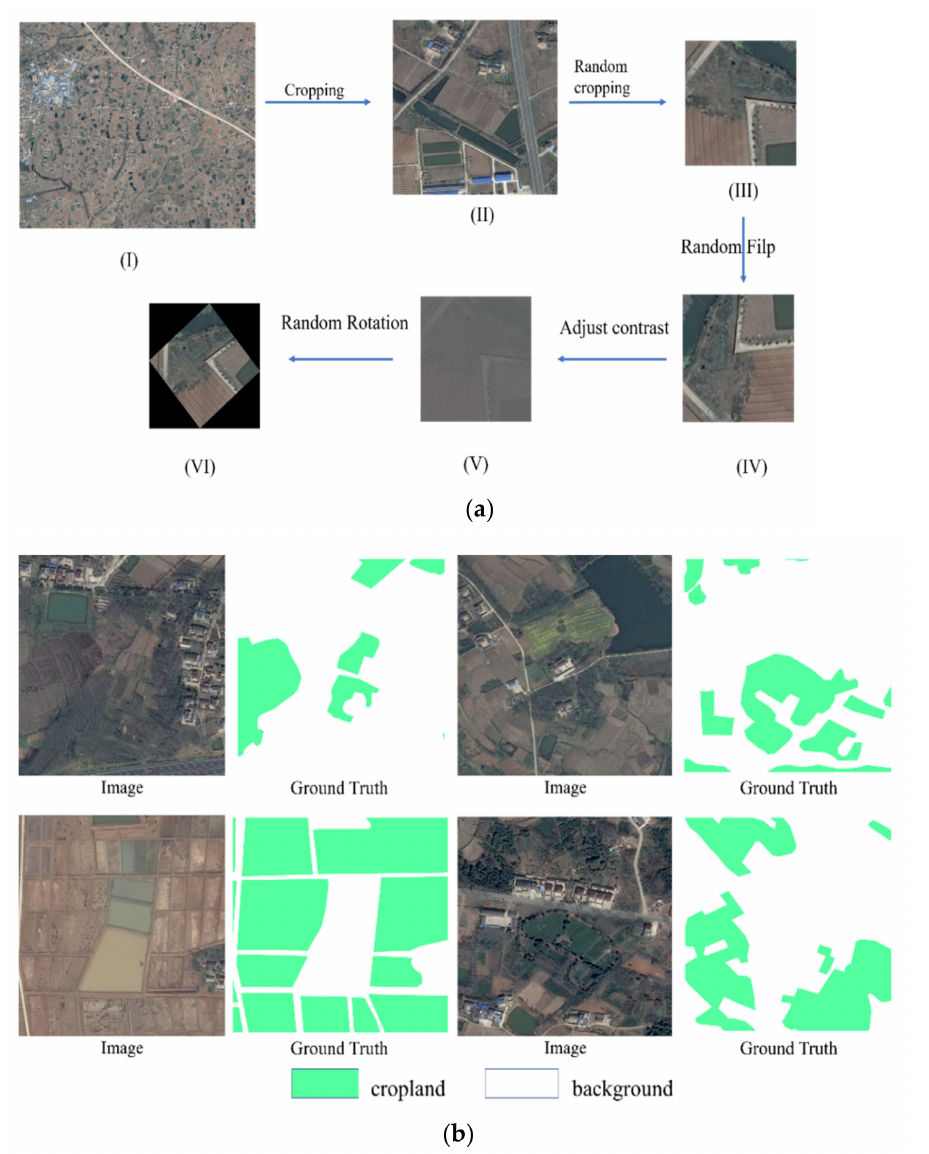
Figure 10. ( a ) The main steps of data processing. The figure shows several data enhancement methods, including random copping, adjust contrast, and random rotation. These methods are random selection in order. ( b ) Original images of some of the cropland and the labeling of the cropland